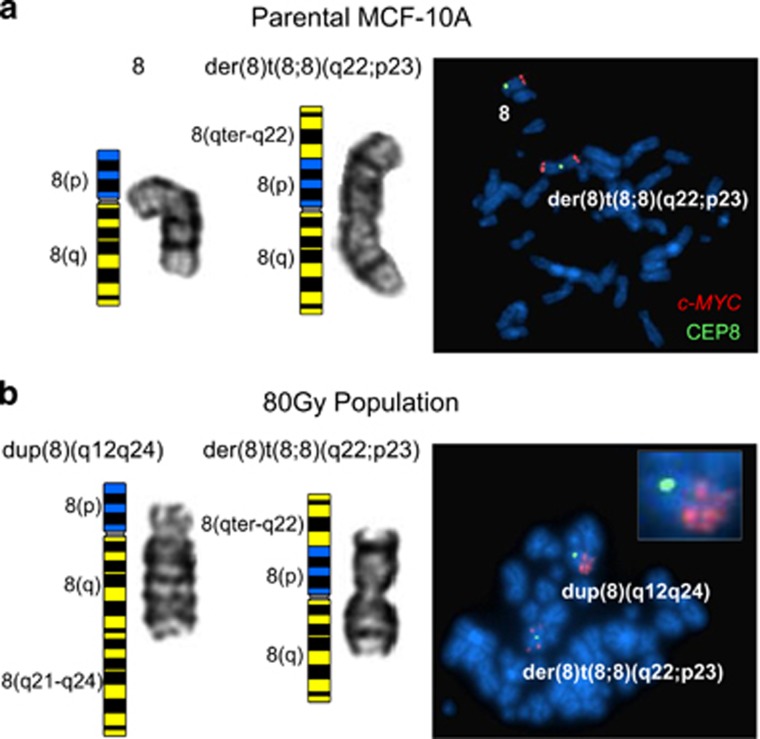
Alterations that affect c-MYC in MCF-10A cells. Partial karyotype analyses of chromosomes 8 and FISH analysis for c-MYC (red probe) and chromosome 8 centromere (green probe) on 4′,6-diamidino-2-phenylindole (DAPI) counterstained metaphase nuclei in parental MCF-10A (a) and 80 Gy cumulative dose cells (b). Chromosome arms are labelled on the ideograms adjacent to the karyotype images. The 46 Mb region of chromosome arm 8q gain present in parental MCF-10A cells is due to a duplication of 8qter-q22 and subsequent translocation to the end of the short arm resulting in a derivative chromosome 8: der(8)t(8;8)(q22;p23). The der(8)t(8;8)(q22;p23) is identified in both the parental and 80 Gy MCF-10A cell populations. The 80 Gy population has a second abnormal chromosome 8, which comprises a tandem duplication of the 8q12–q24 region to the q-telomere of the constitutively normal chromosome 8: dup(8)(q12–q24). FISH analysis confirmed that c-MYC is present in both the constitutive 46 Mb region of gain on der(8)t(8;8)(q22;p23) and the duplicated region on dup(8)(q12–q24) identified in the 80 Gγ population. The magnified view of the acquired dup(8)(q12–q24) chromosome in the 80 Gγ population (inset in b) shows that multiple copies of c-MYC are present at both expected 8q24 chromosome positions.